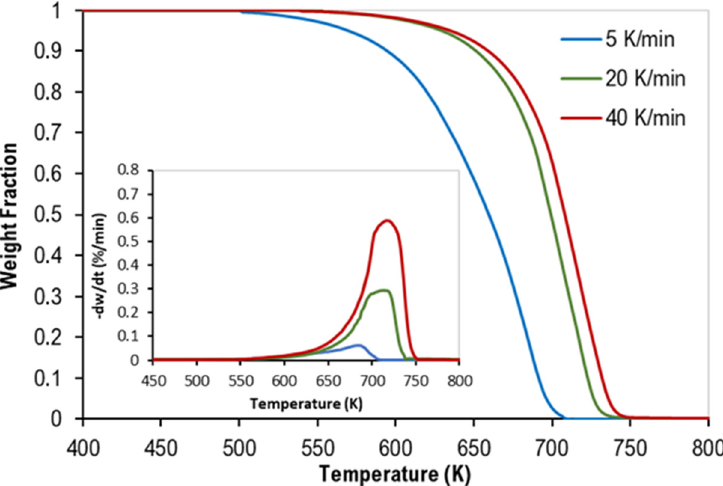
Figure 1. TG curves of binary mixtures of PP and PS with DTG curves inside.